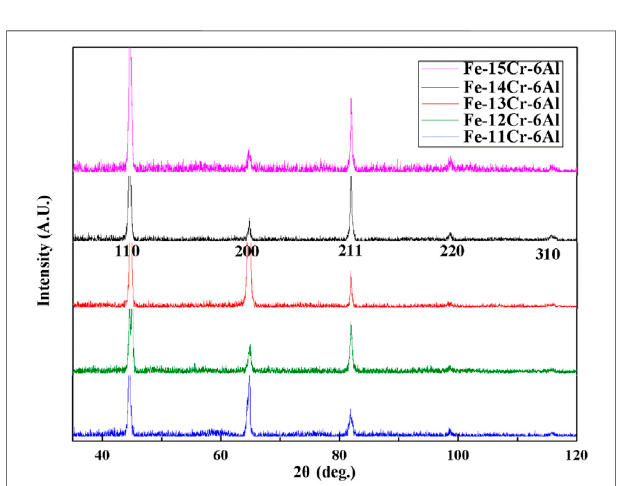
FIGURE 2 | X-ray diffraction patterns of Fe – x Cr – 6Al with different compositions.